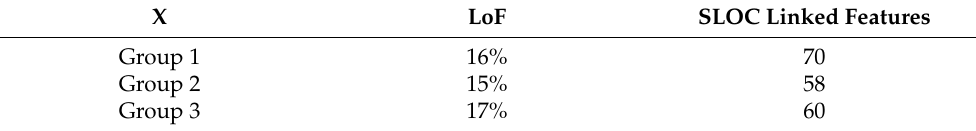
Table 4. Lines of code of features quantified in the execution of the case study with IRArduino-SPL.